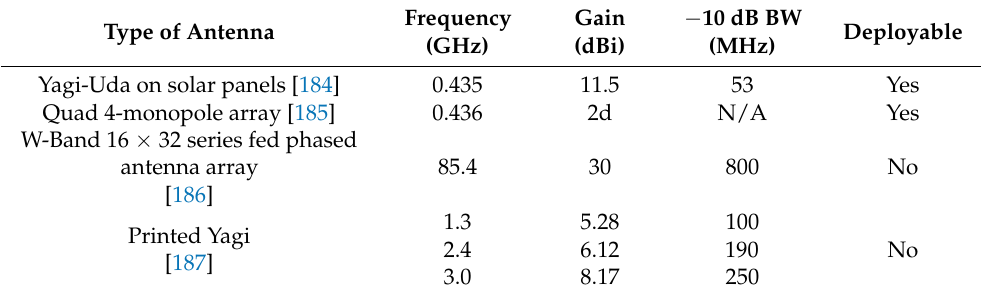
Table 11. Performance of linear antenna arrays. Type of Antenna